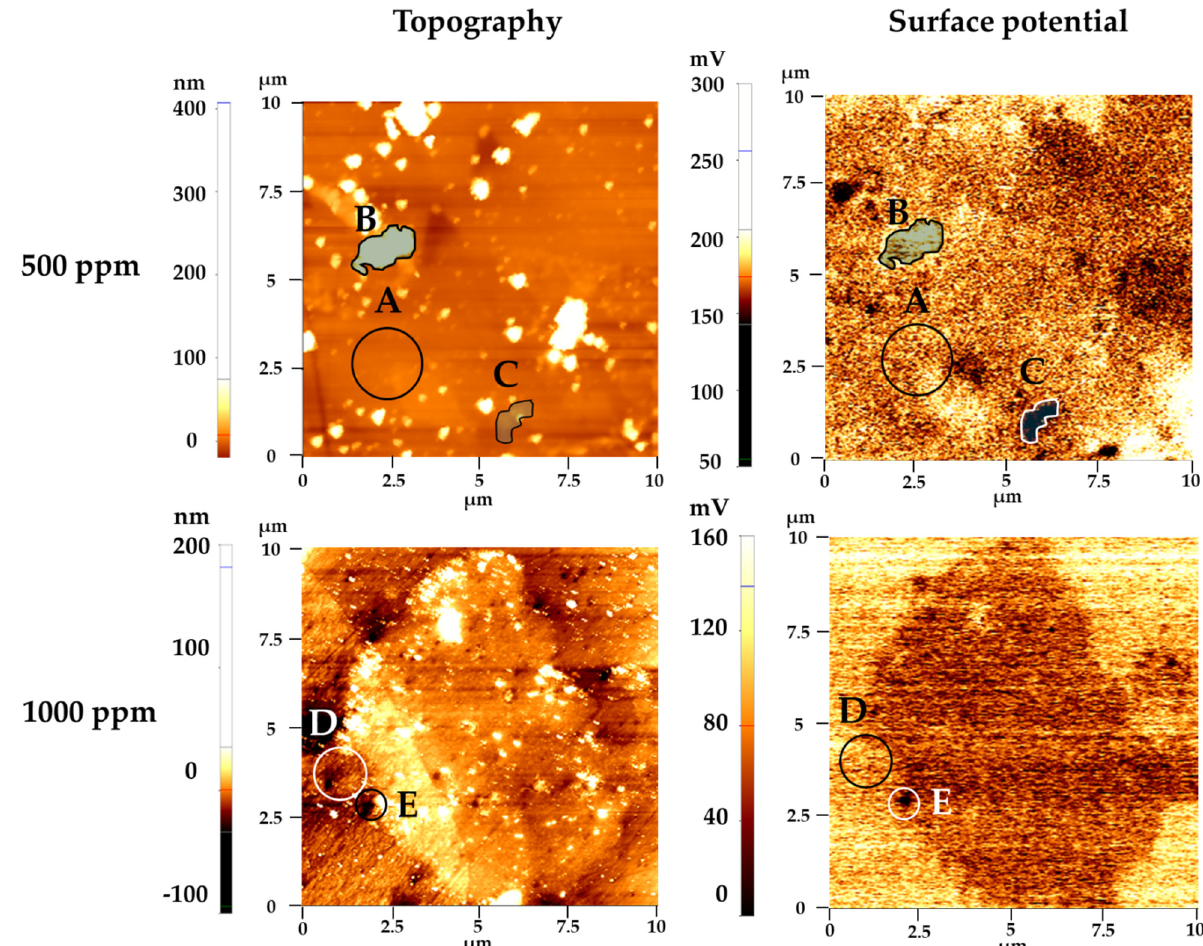
Figure 8. Topography and surface potential of carbon steel weldment after 6 h immersion in 500 and 1000 ppm of imidazole solution as measured by AFM with SKPFM mode . Table 5. Difference of surface potential between distinctive areas in results of AFM measurement .